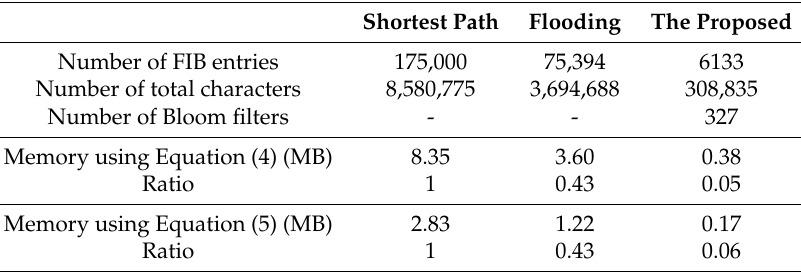
Table 3. Memory consumption of AS-6461.